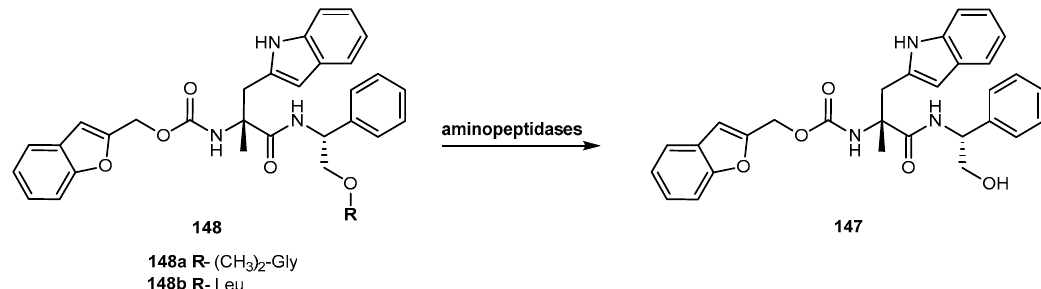
Figure 62. Bioconversion of amino acid ester prodrugs ( 148a ) and CAM-4580 ( 148b ) to its parent